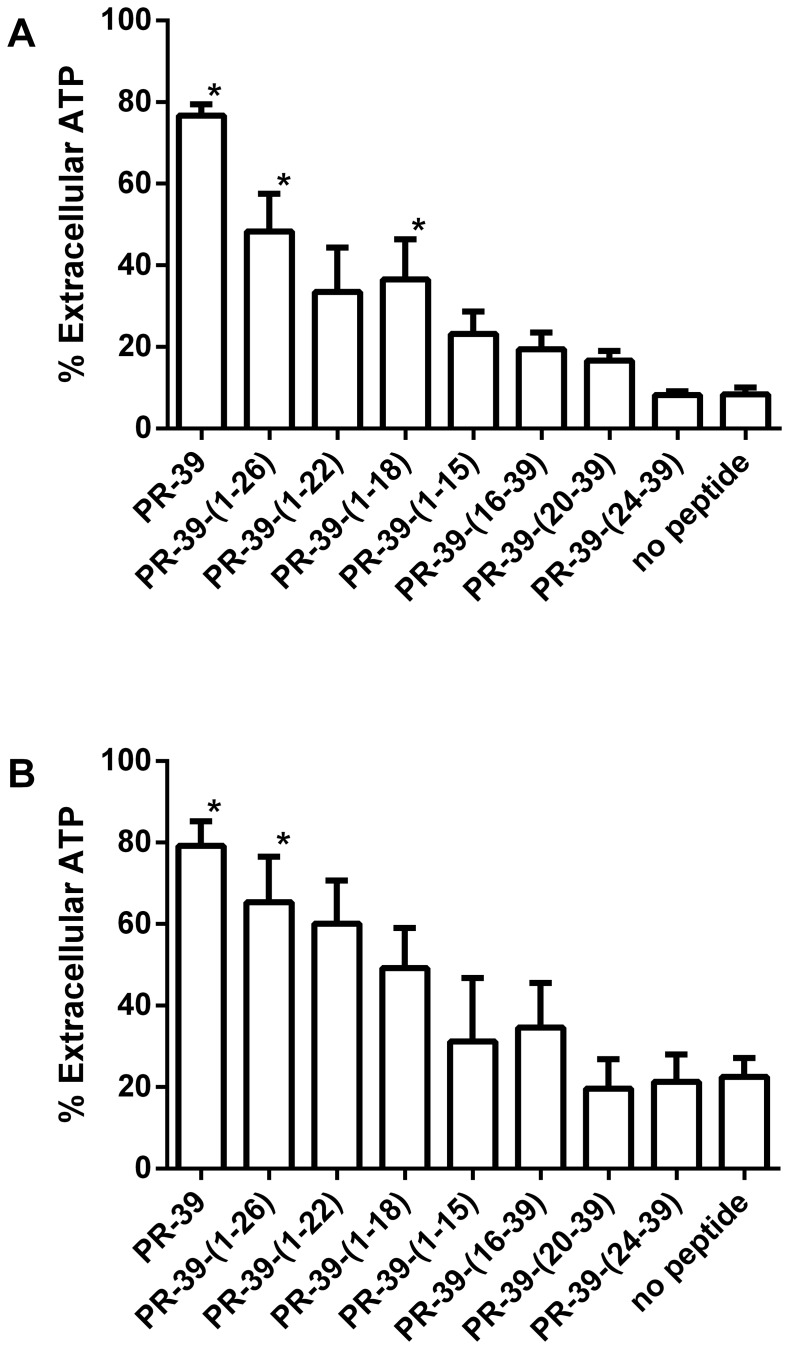
PR-39 derived peptides cause release of bacterial ATP.Bacteria were incubated for 5 µM peptides. ATP in supernatant and cell pellet were determined using a luciferase bioluminescence kit. A: E. coli, B: B. globigii. Shown are mean ± SEM of at least three independent experiments in triplicate. *: p<0.05 compared to the no-peptide control.